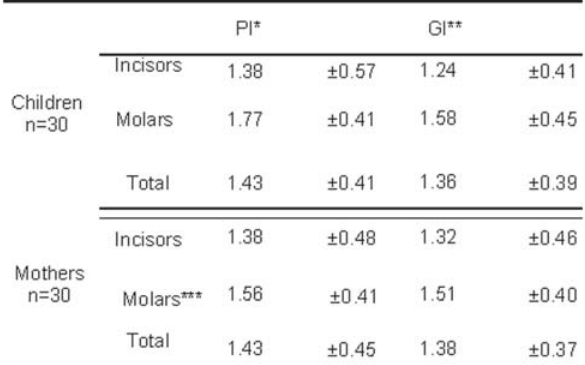
TABLE 1- Mean values of plaque and gingival indexes of children and mothers for incisors, first permanent molars and total teeth